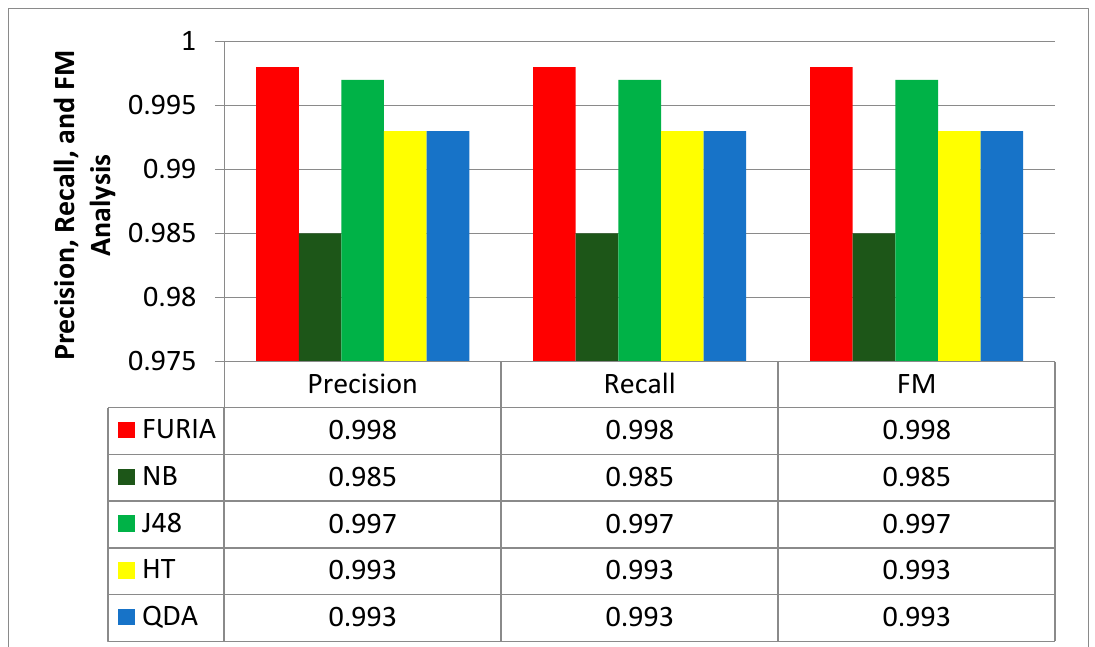
Figure 5. Models comparison based on precision, recall, and F-measure.